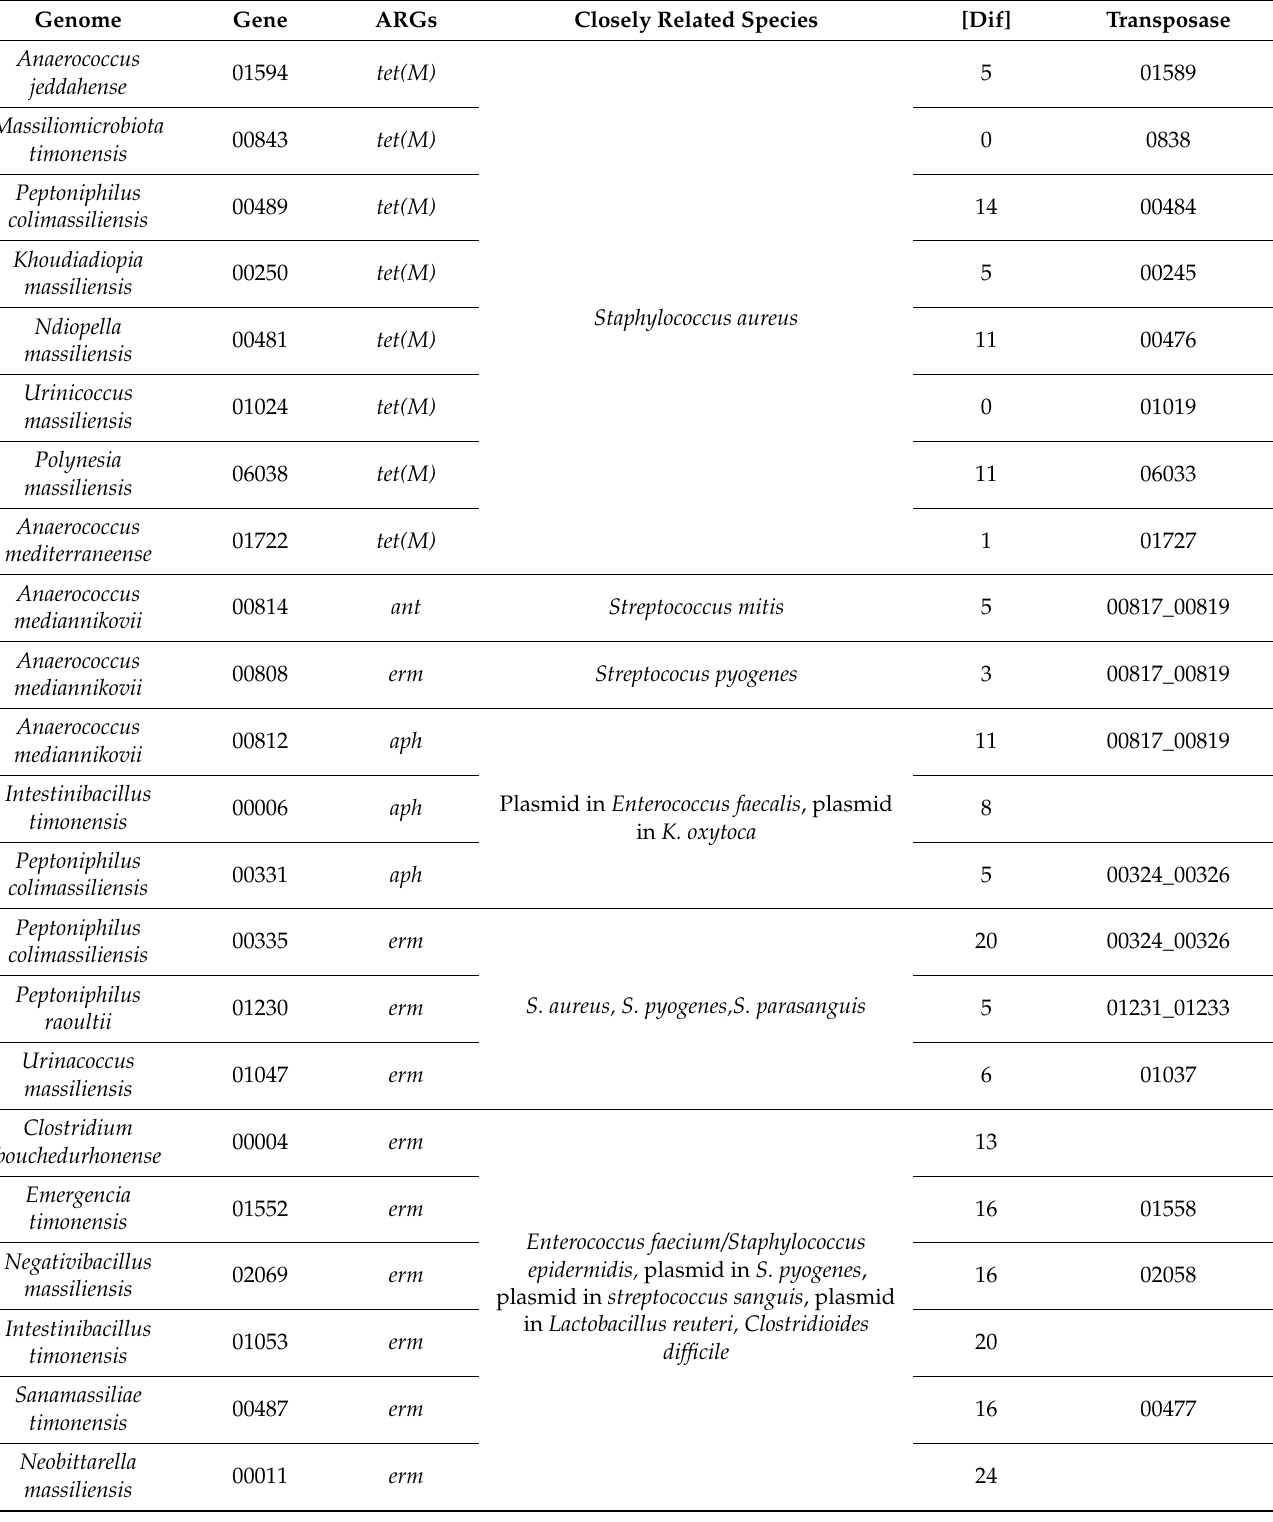
Table 3. ARGs found in the genomes of human microbiota that can be issued from lateral transfer according to the closely related species found in robust phylogenies, the difference between their GC content and the mean GC% of the genomes (Dif) and the presence of transposases nearby. Species in red indicate the possible en bloc transfer. * indicates prophage integrase and plasmid recombination enzyme five proteins upstream or downstream of the specific